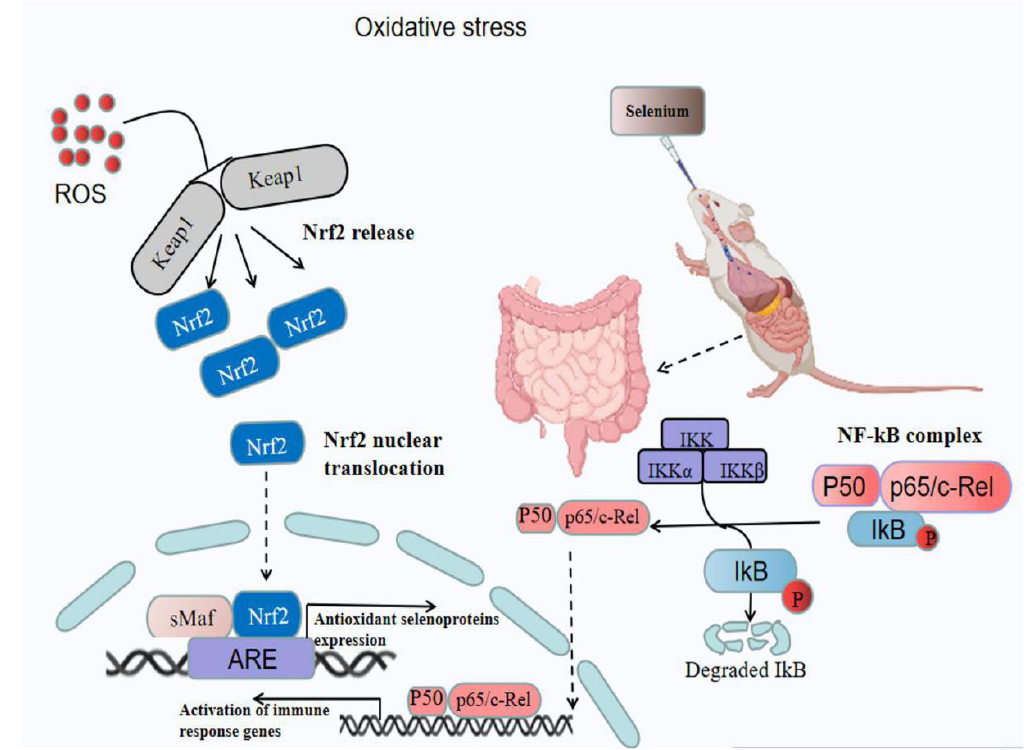
Figure 2. Selenium affects the typical pathways of intestinal disease.